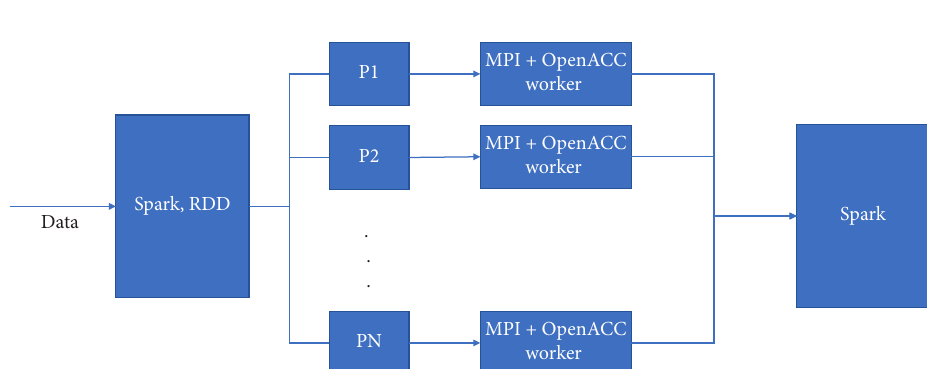
Figure 2: Simple integration of Spark, MPI, and